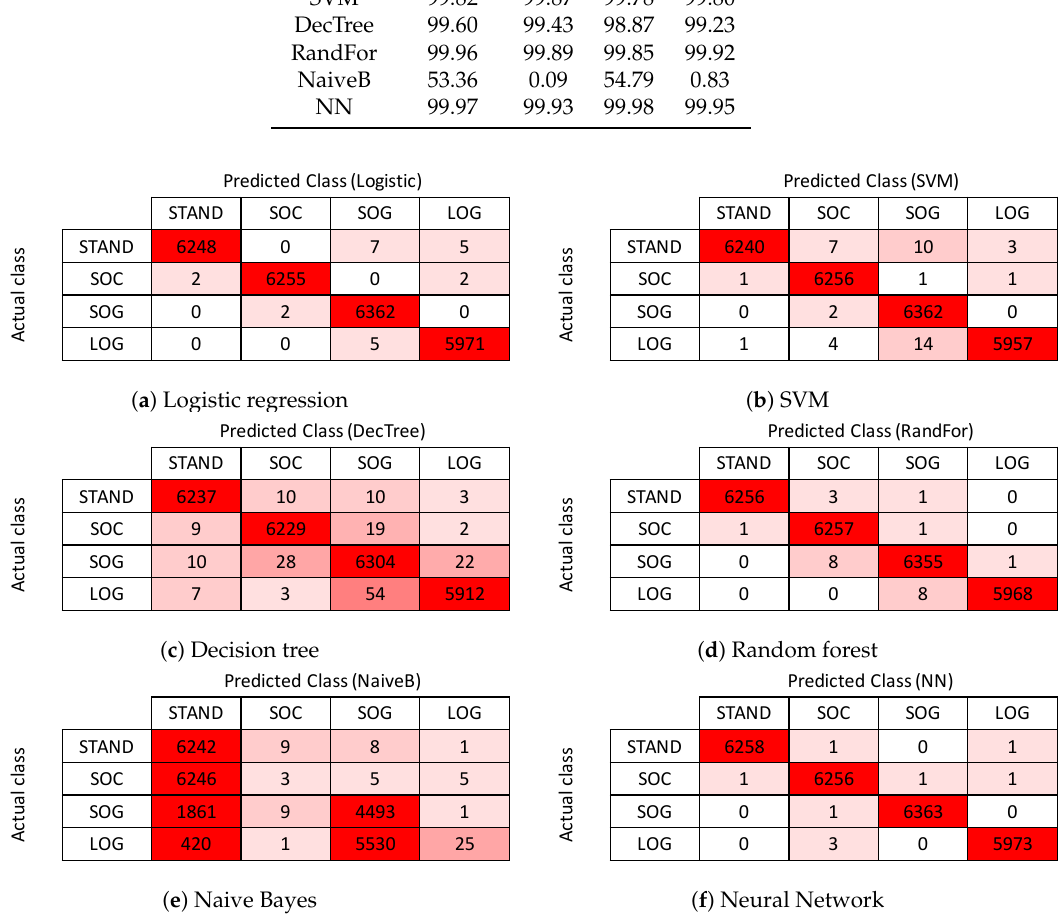
Figure 8. Confusion matrix results for all activities detection using all learning